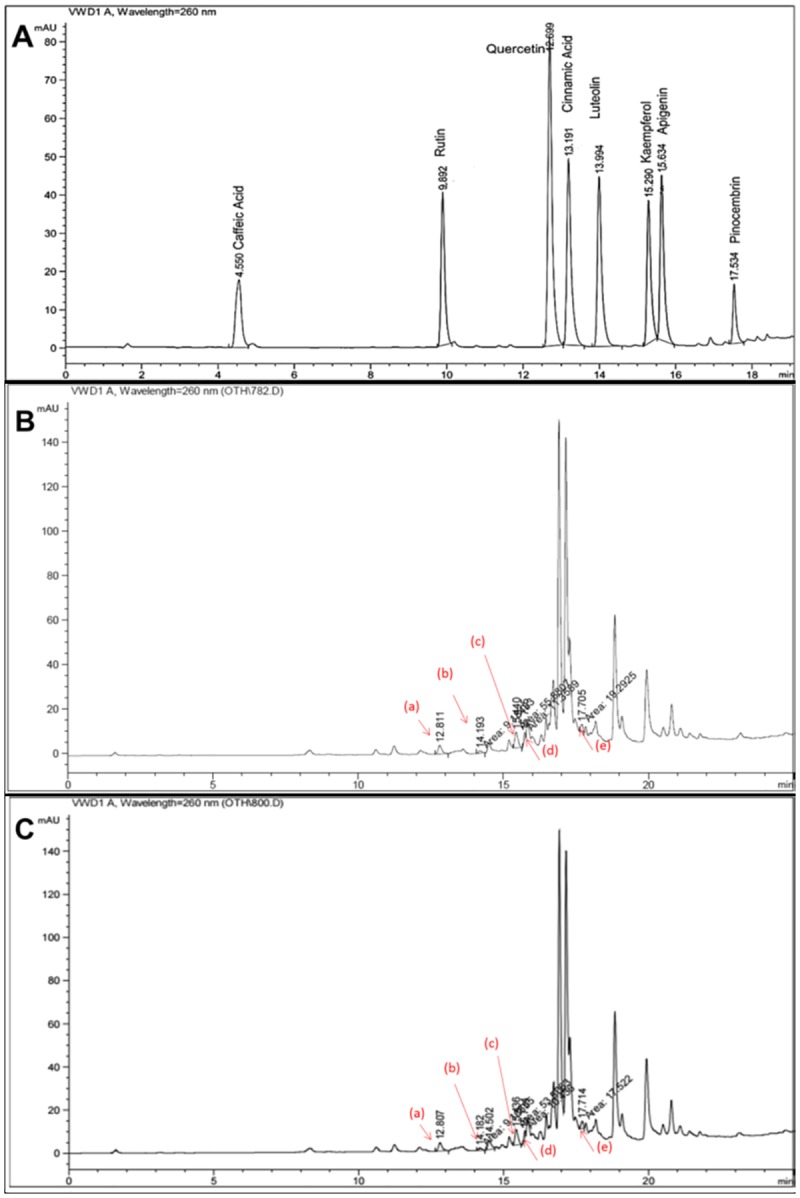
HPLC chromatograms depicting the elution profile of standard flavonoid compounds and extracts of Malaysian propolis by gradient method.A) Chromatographic profile of the flavonoid standards caffeic acid, rutin, quercetin, cinnamic acid, luteolin, kaempferol, apigenin and pinocembrin. B and C) Chromatographic profile of Malaysian propolis Eth extract (B) or EA extract (C) depicting the presence of the flavonoids (a) Quercetin (b) Luteolin (c) Kaempferol (d) Apigenin (e) Pinocembrin represented by the peaks marked with arrows. Caffeic acid, rutin and cinnamic acid were not detected in either of the extracts.